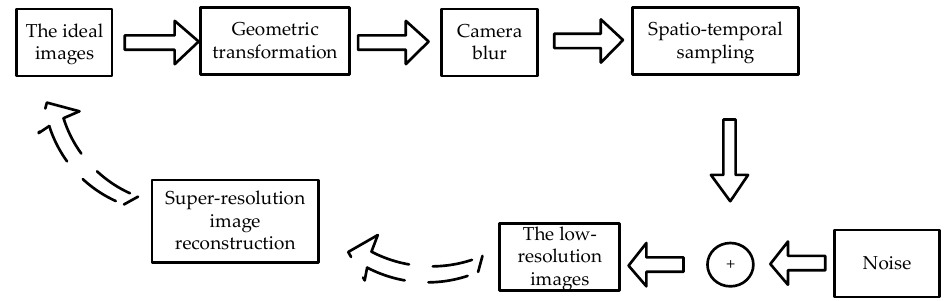
Figure 4. Model for generating low-resolution images.